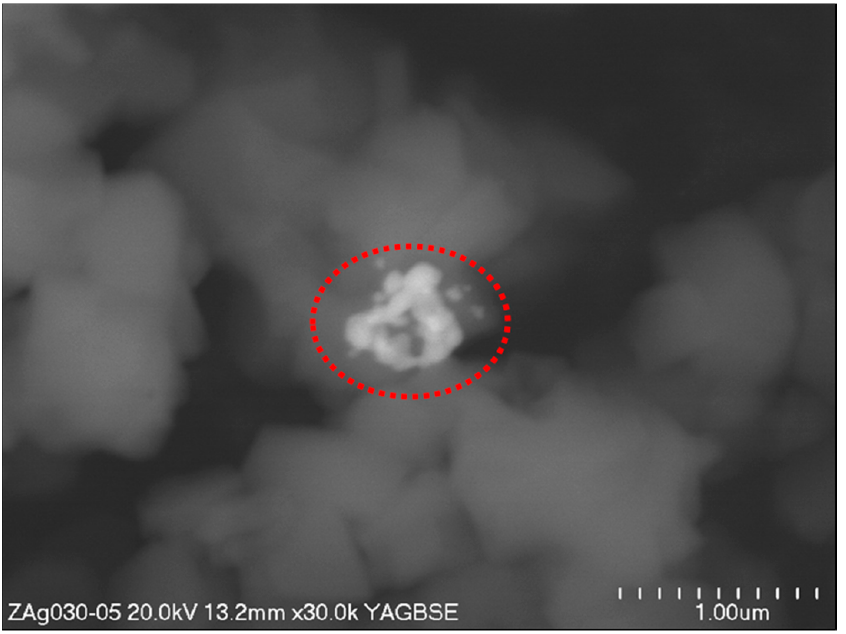
Figure 4. SEM image of faujasite exchanged with silver cations (as ZAg+)—area of interest is marked by red circle.